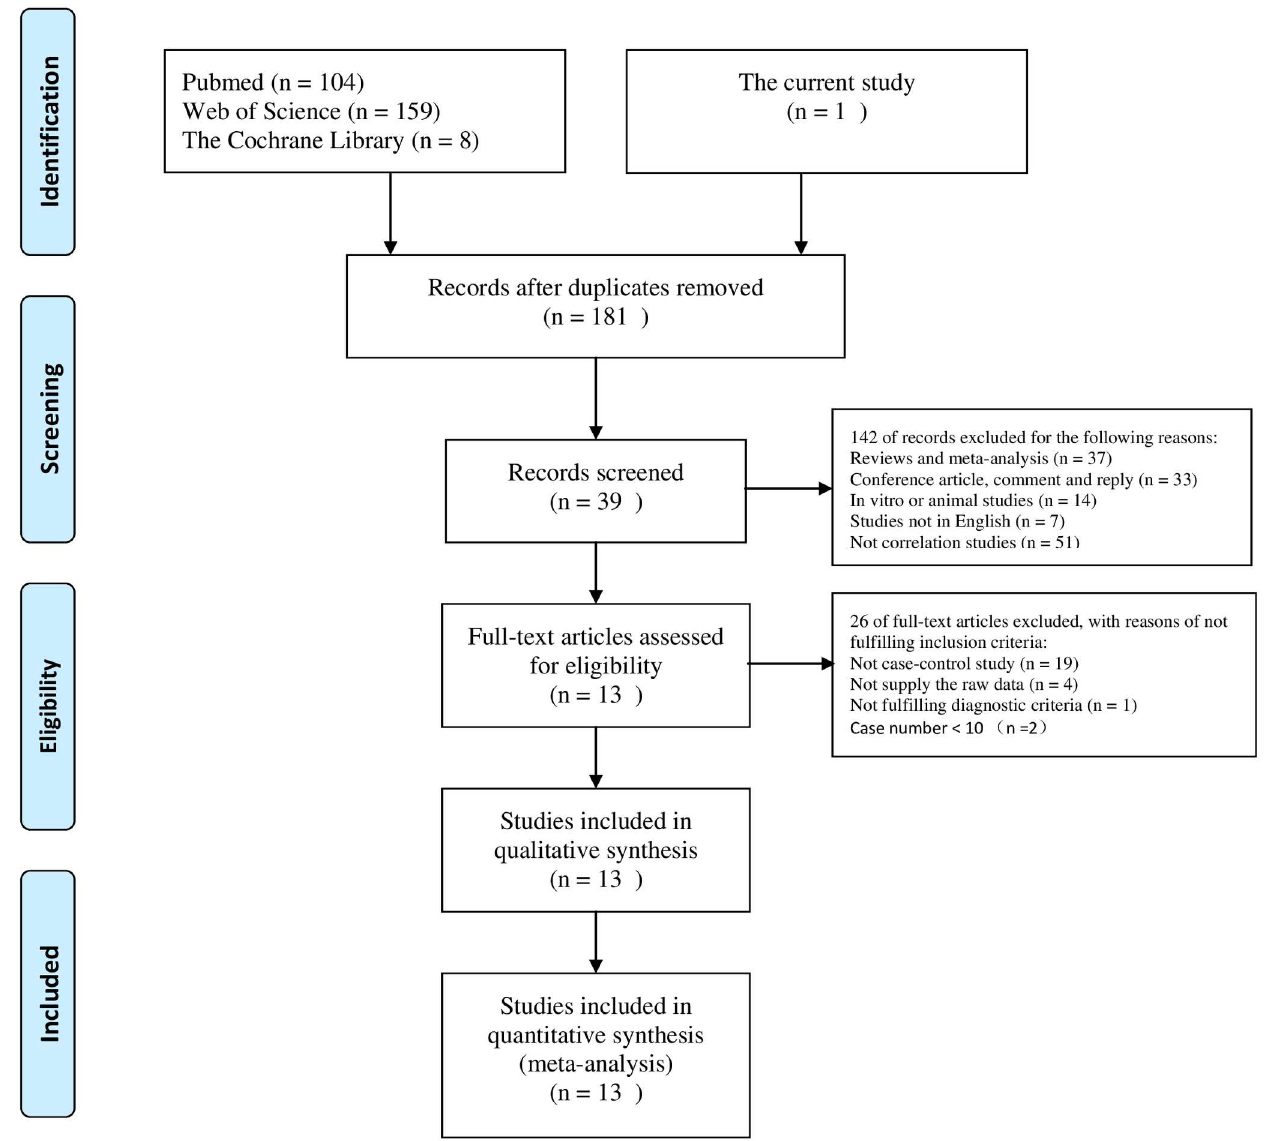
Fig 1. Flow diagram of the study selection process in the